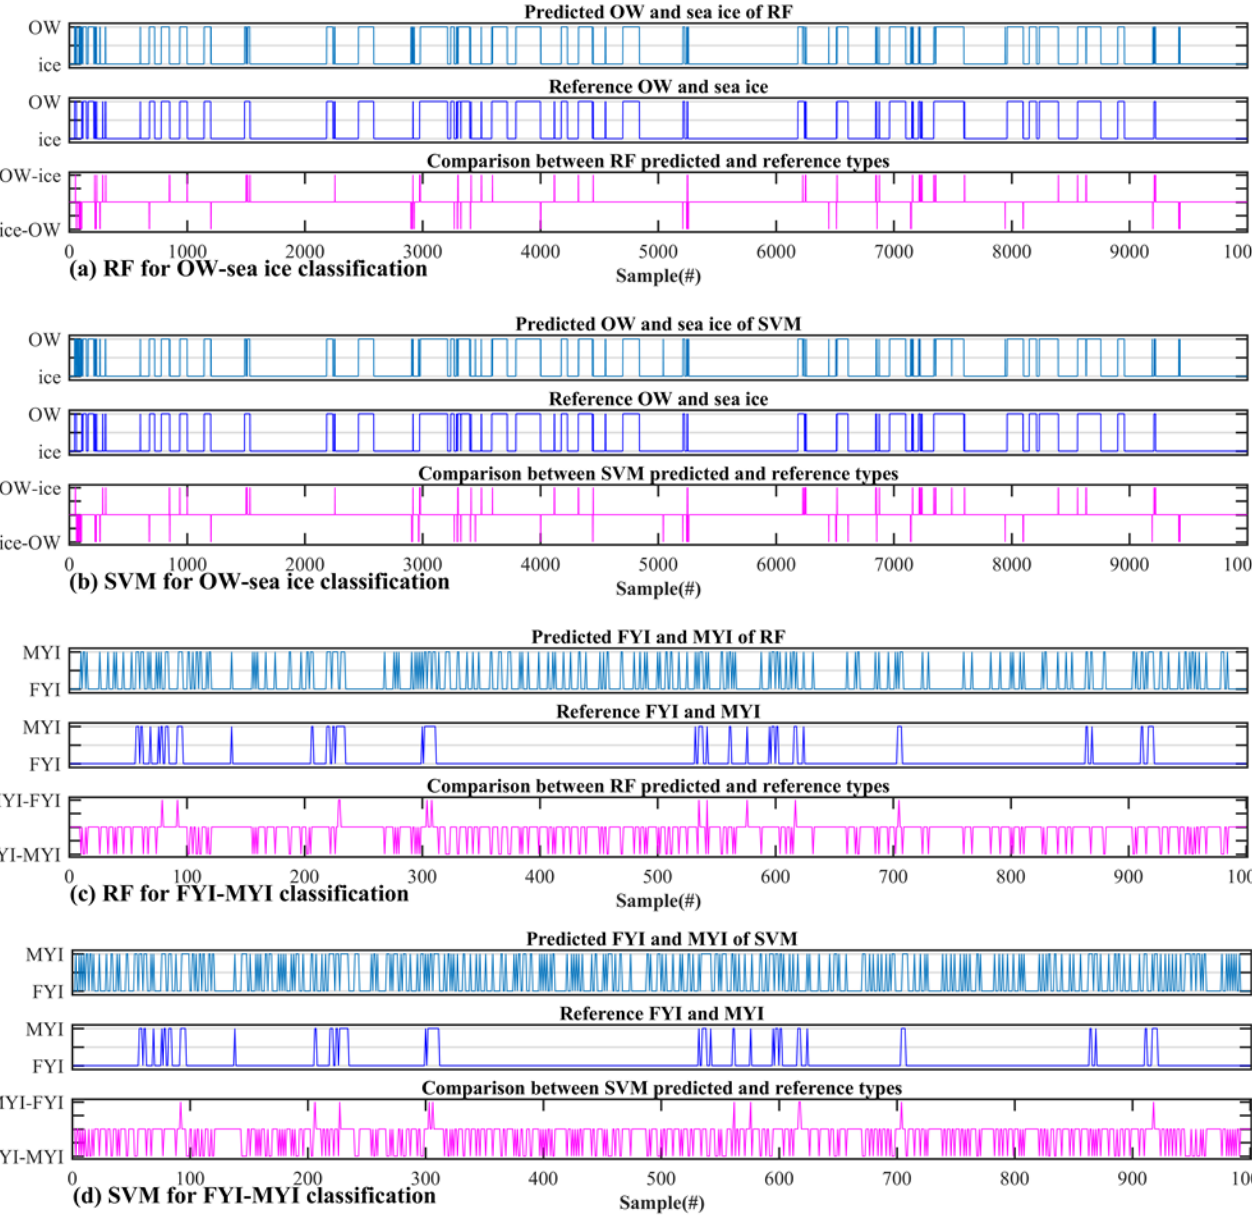
Figure 13. Parts of classification results of random forest (RF) and support vector machine (SVM) classifiers. Zoomed ( a ) RF and ( b ) SVM results of 10,000 samples for OW-sea ice classification. Zoomed ( c ) RF and ( c ) SVM results of 1000 samples for FYI-MYI classification. In each figure of ( a ) to ( d ), the top plot represents the predicted types of the classifier, the middle one is the reference types from OSISAF SIT and the lowest one is the comparison results between predicted and reference types. OW-ice means the OW is misidentified as sea ice, and ice-OW means the sea ice is misclassified as OW. FYI-MYI means the FYI is misidentified as MYI, and MYI-FYI means the MYI is misclassified as FYI.